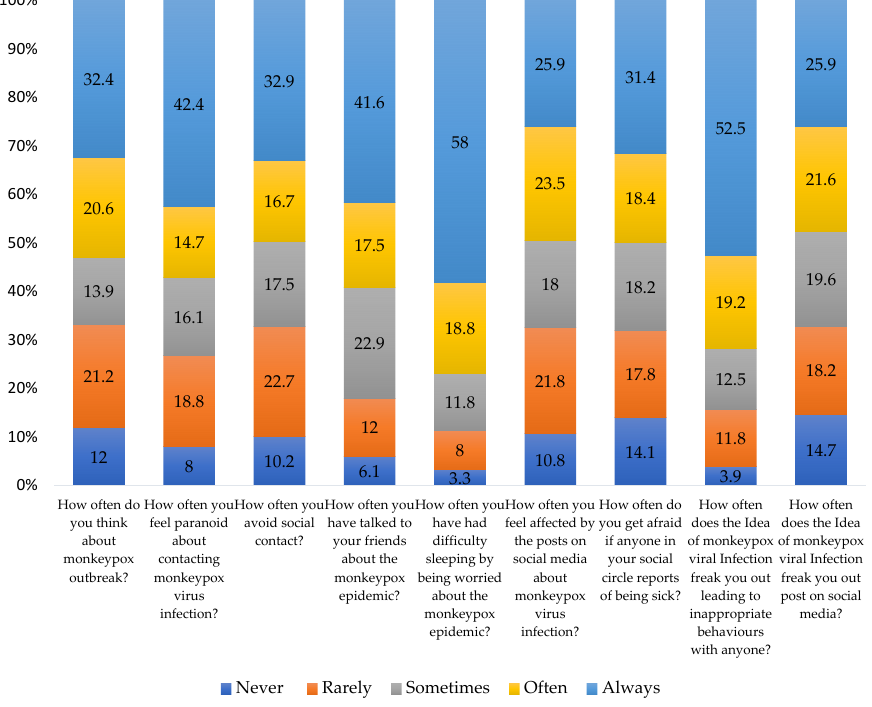
Figure 3. Worry related mpox outbreak in 2022 ( n = 510).